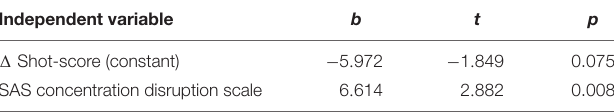
TABLE 6 | Summary of analysis of multiple linear regression for change in shooting score. Independent